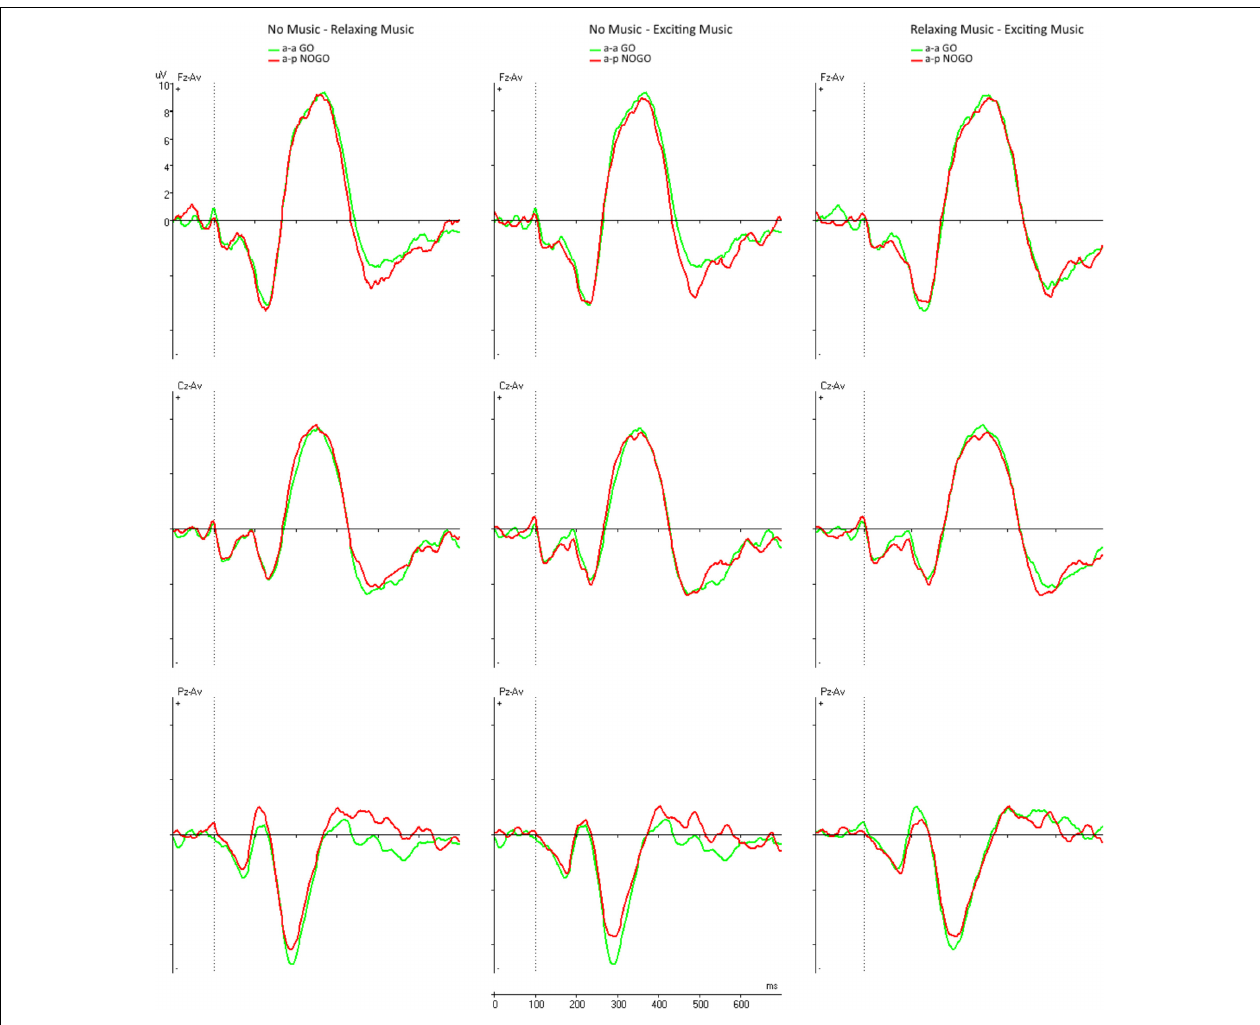
FIGURE 3 | Difference waves at midline electrodes Fz, Cz, and Pz across the conditions. Left column = NM and RLX, middle column = NM and EXC, right column = RLX and